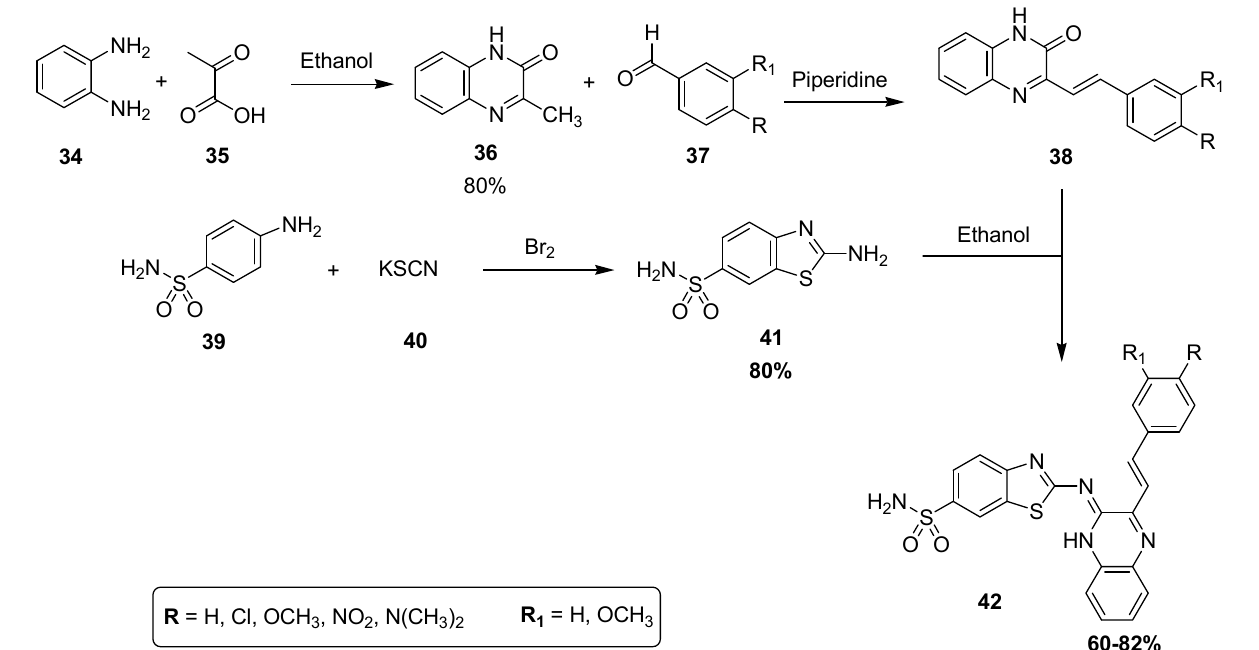
Scheme 1. Synthesis of sulfonamide derivatives 42.